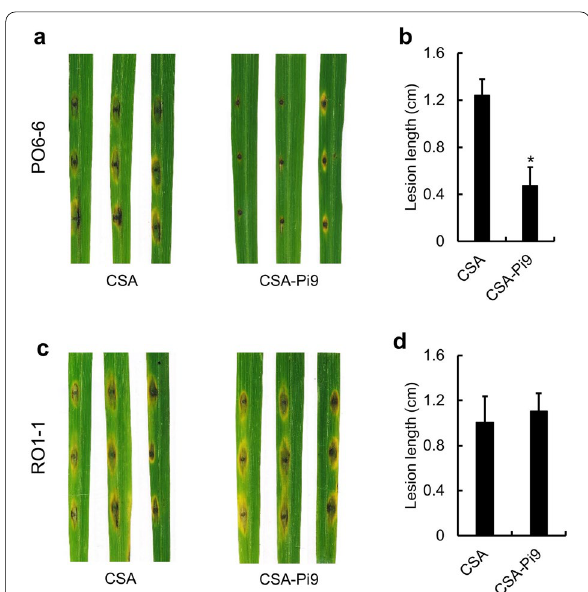
Fig. 3 AvrPi9 phenotyping and validation of Pi9 ‑mediated resistance. Photographs of lesions ( a ) and quantification of lesion length ( b ) in CSA‑Pi9 and CSA leaves inoculated with PO6‑6 (incompatible isolate). Photographs of lesions ( c ) and quantification of lesion length ( d ) in CSA‑Pi9 and CSA leaves inoculated with RO1‑1 (compatible